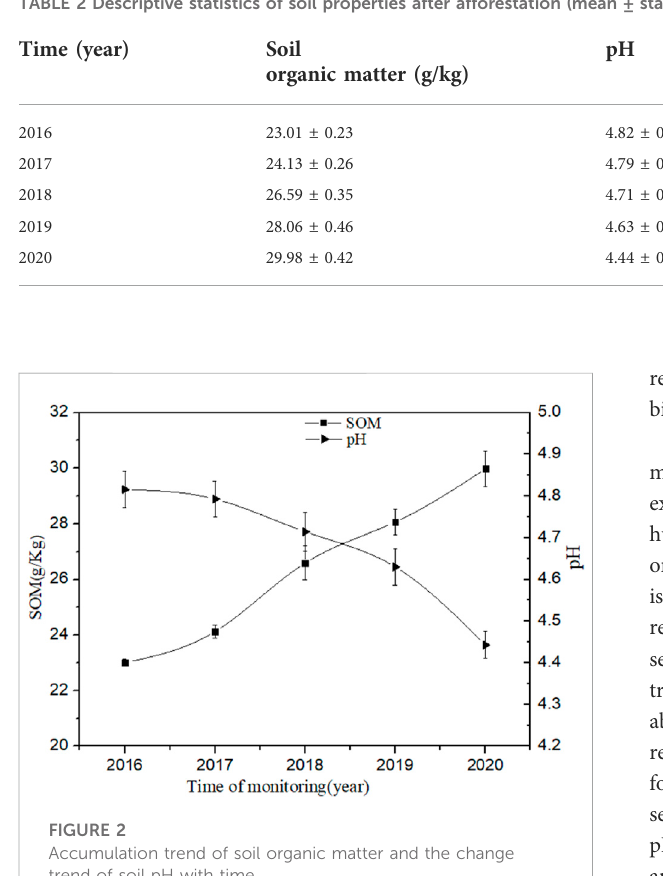
TABLE 2 Descriptive statistics of soil properties after afforestation (mean ± standard deviation, n = 7).